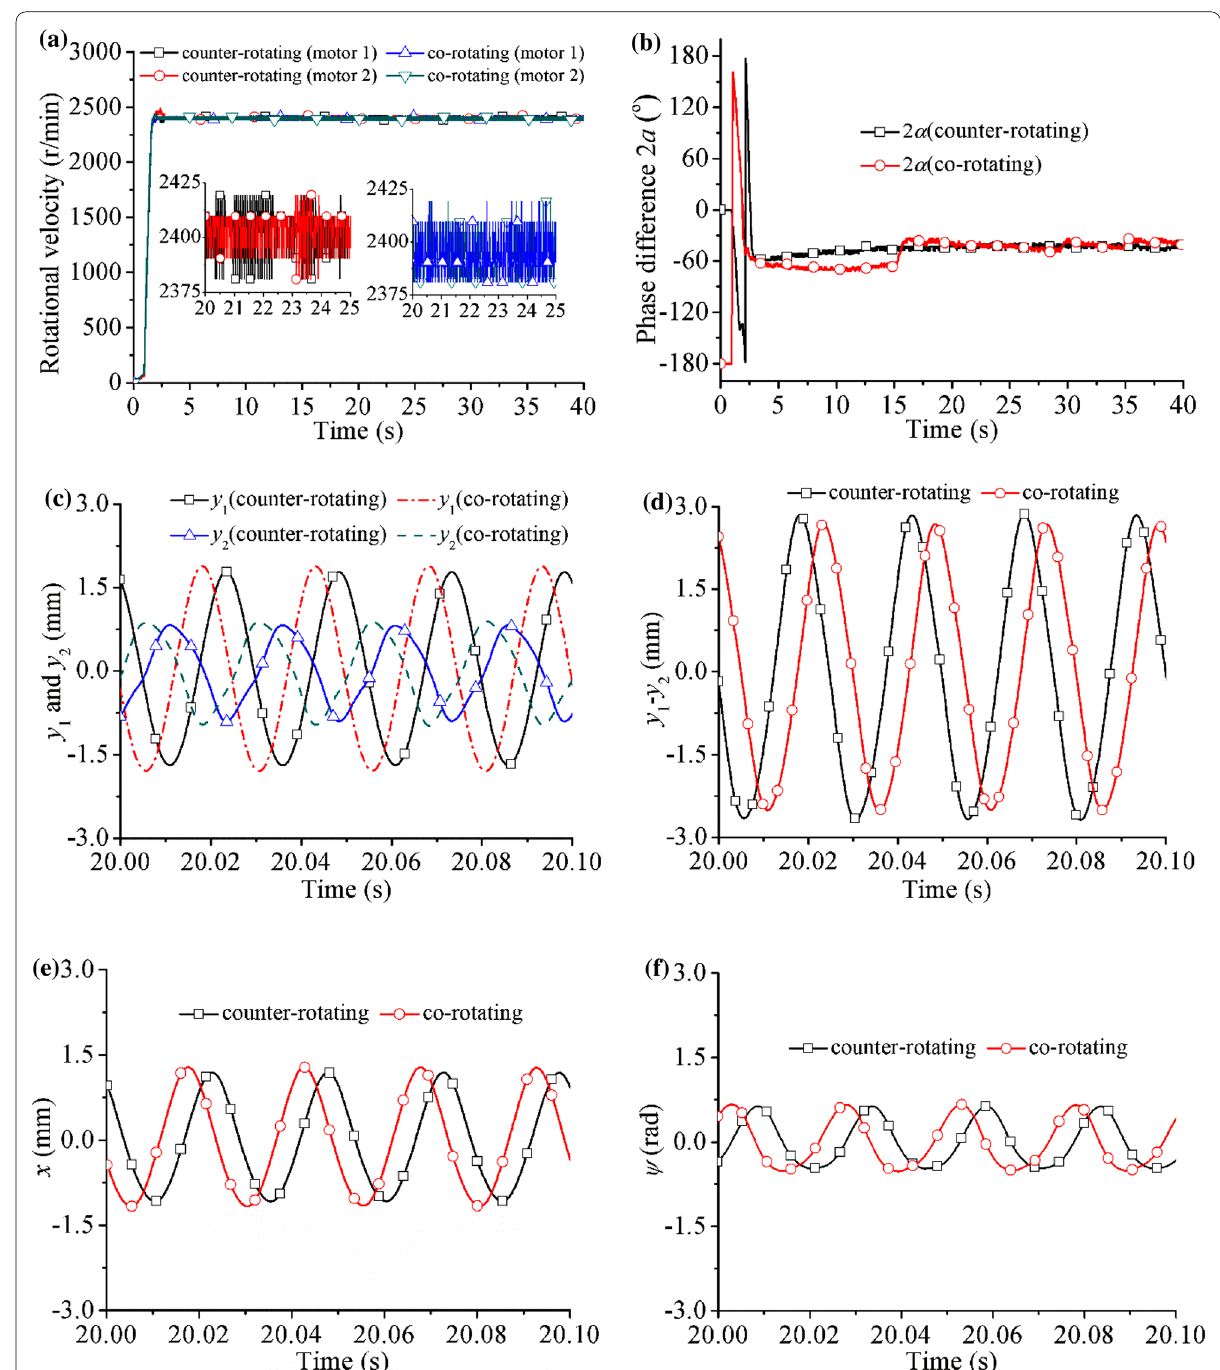
Figure 7 Experimental results in the sub-resonant state for ω 0 : a Rotational velocities of the two motors, b Phase difference between the two vibrators, c Displacement: y 1 and y 2 in the steady state, d Displacement: y 1 Displacement: ψ in the steady